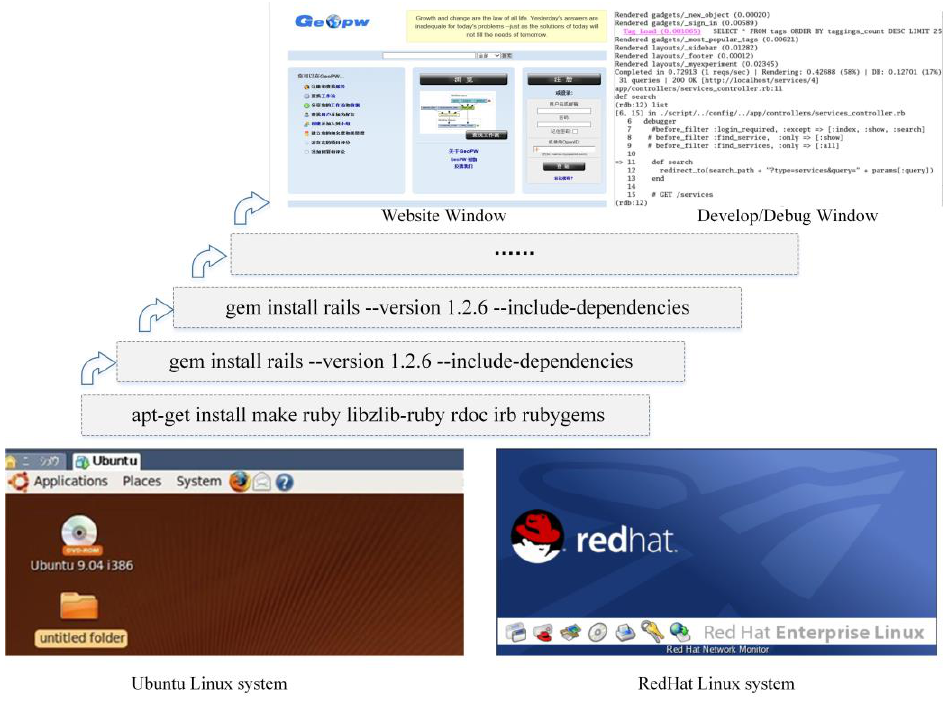
Figure 2. The process of building the platform running